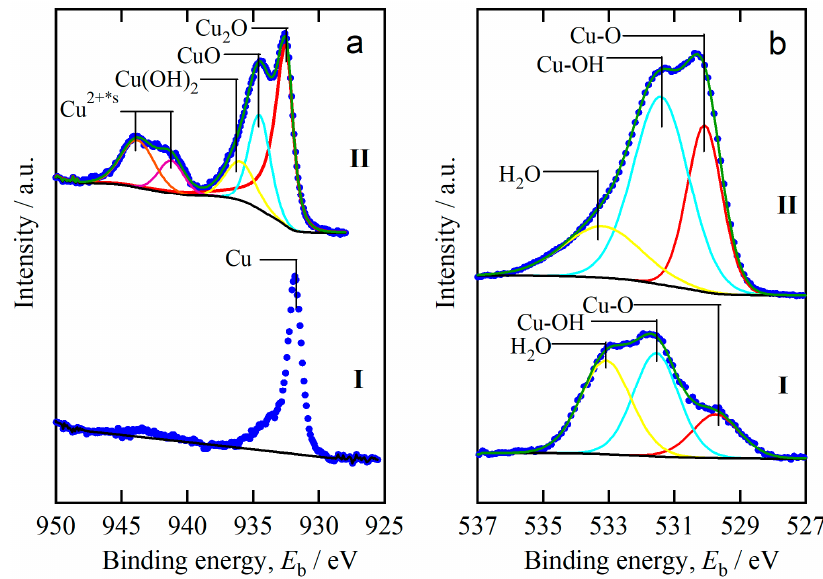
Figure 6. XPS spectra of Cu 2p ( a ) and O 1s ( b ) of nanoporous Cu before ( I ) and after ( II ) free immersion in anhydrous ethanol.